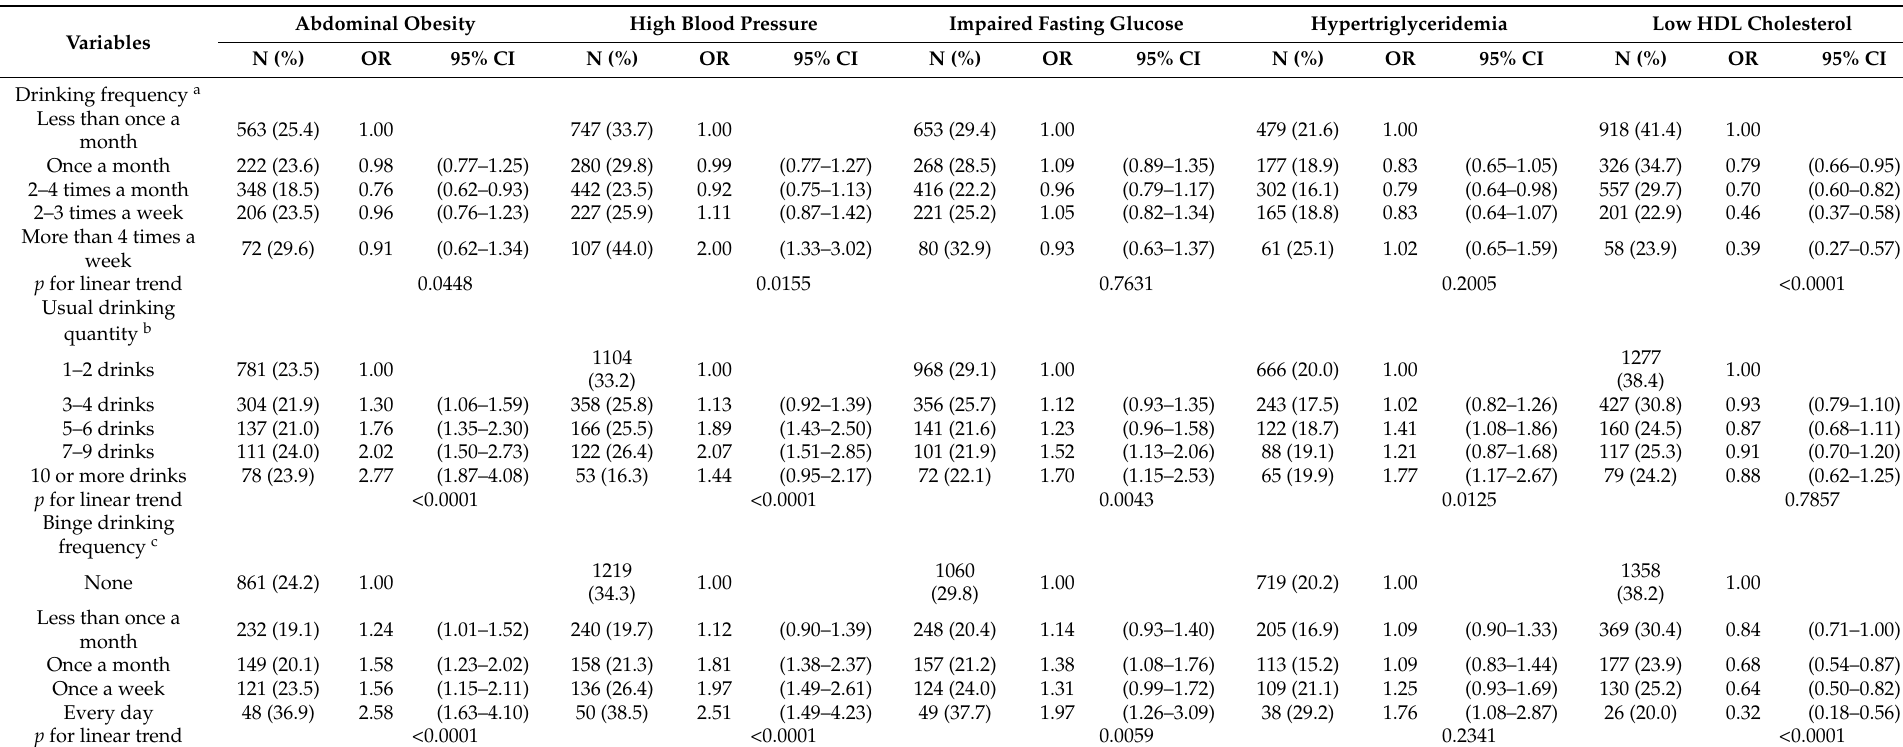
Table 4. The association between alcohol drinking patterns and components of metabolic syndrome in